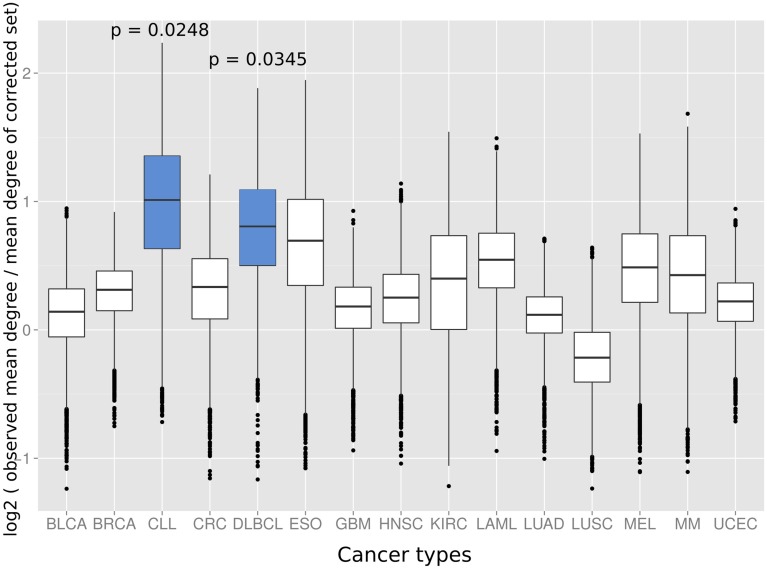
The distributions show the log2 of the mean degree of proteins of the specific cancer type divided by the mean degree of 10,000 randomized protein sets with the same bait usage distribution (a value of 0 would therefore signify that the mean degree of the cancer protein set equals the observed mean degree of the random protein set, positive values that the mean degree of the proteins of the respective cancer type is higher than for the random set and, vice versa, negative values that the mean degree of the random set proteins is higher as for the proteins of the cancer type). Blue boxes indicate that the mean of the original degree distribution of the respective cancer type is significantly higher (p < 0.05; randomization test) as those of randomized protein sets with the same bait usage distribution. The cancer types on the x-axis are: BLCA, bladder cancer; BRCA, breast cancer; CLL, chronic lymphocytic leukemia; CRC, colorectal cancer; DLBCL, diffuse large B-cell lymphoma; ESO, esophageal adenocarcinoma; GBM, glioblastoma multiforme; HNSC, head and neck cancer; KIRC, kidney clear cell carcinoma; LAML, acute myeloid leukemia; LUAD, lung adenocarcinoma; LUSC, lung squamous cell carcinoma; MEL, melanoma; MM, multiple myeloma, and UCEC, endometrial cancer.